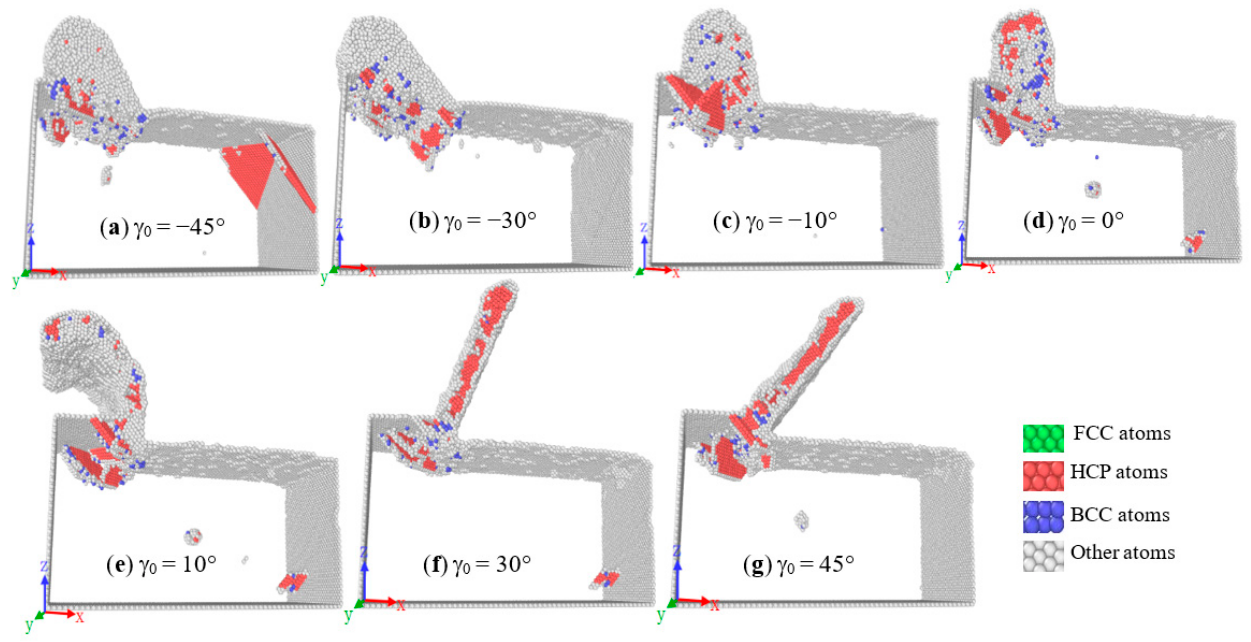
Figure 8. CAN analysis.